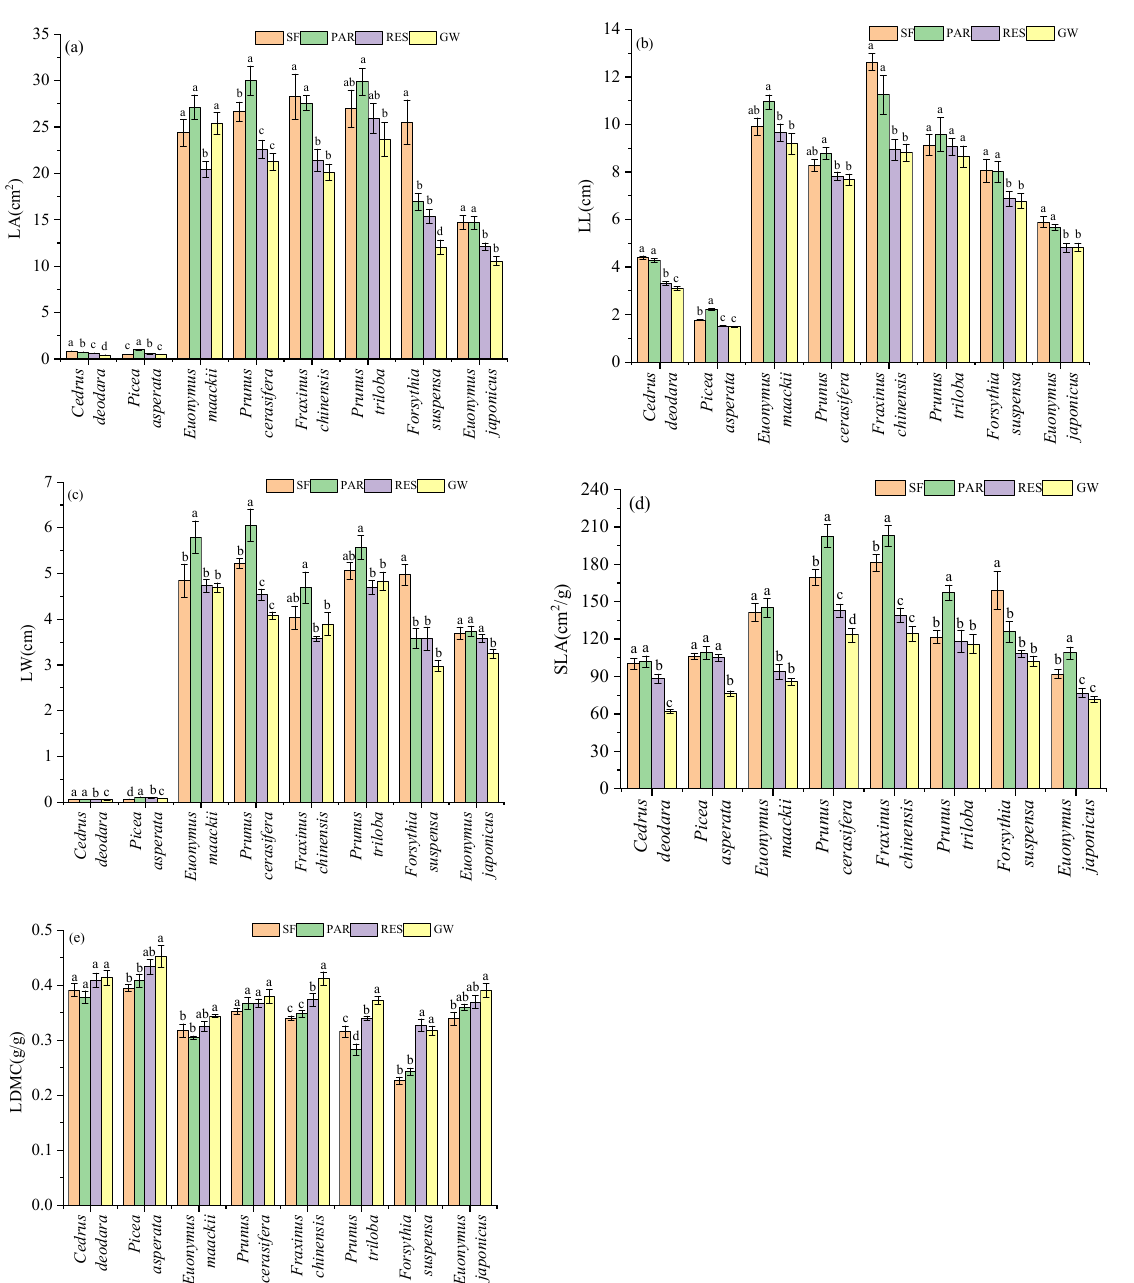
Figure 3. Characteristics of the leaf morphological traits of eight plants in four urban green space environments. SF = sport field; PAR = park; RES = residential green space; GW = greenway. Different letters above the bars indicate significant differences among four urban green spaces: ( a ) leaf area (LA); ( b ) leaf length (LL); ( c ) leaf width (LW); ( d ) specific leaf area (SLA); ( e ) leaf dry matter content